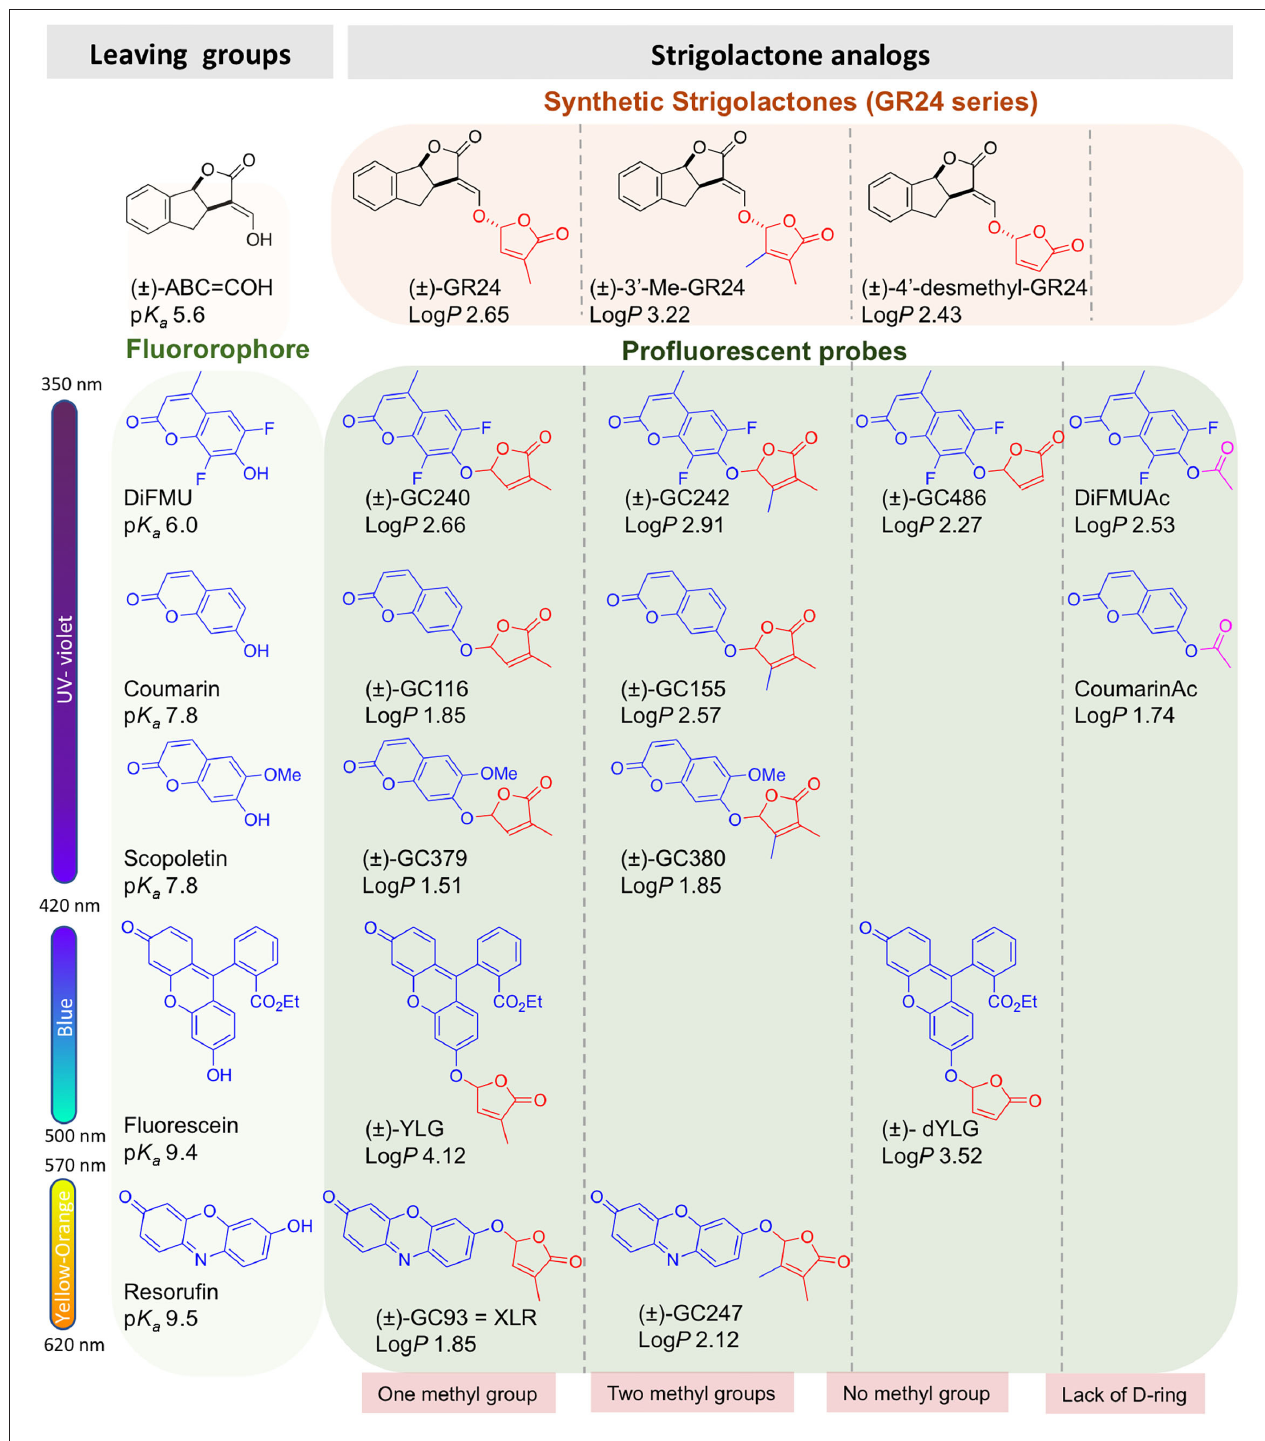
FIGURE 2 | Chemical probes discussed in this study. Log P and p K a are calculated by the ACD program.